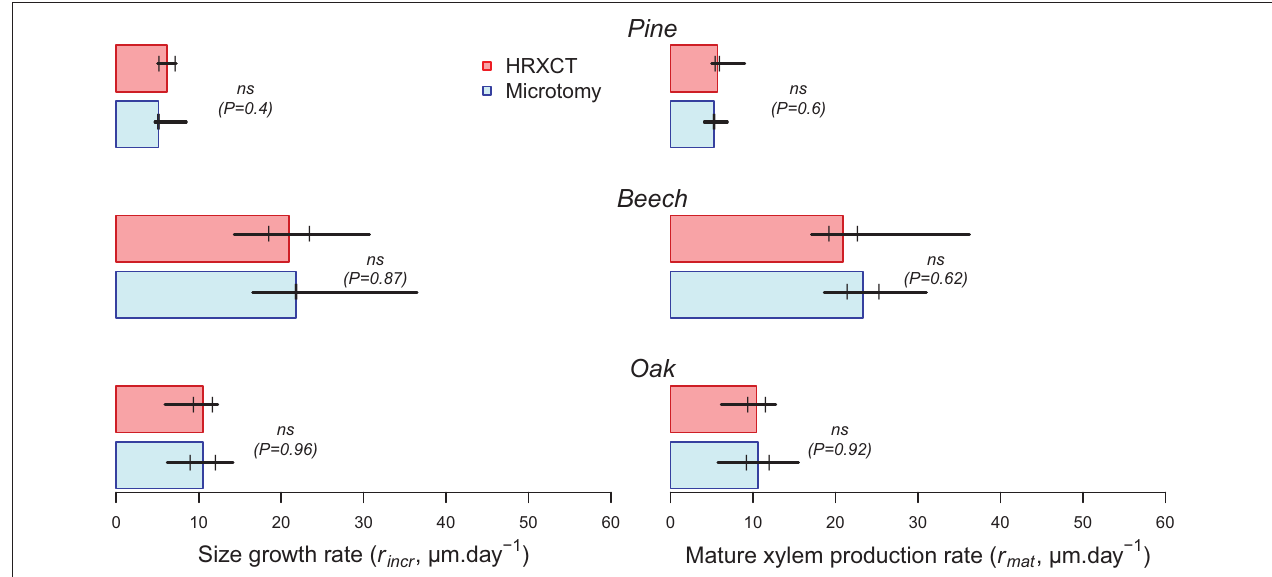
FIGURE 8 | Size growth ( r incr ) and mature xylem ( r mat ) production rates (median) estimated with CT (red) and microtomy (blue). Black lines range from minimum to maximum estimated duration, while second and third quartile are represented by short vertical lines. The significance of the bootstrap resampling test (P) assessing the difference between HXRCT and microtomy is reported.